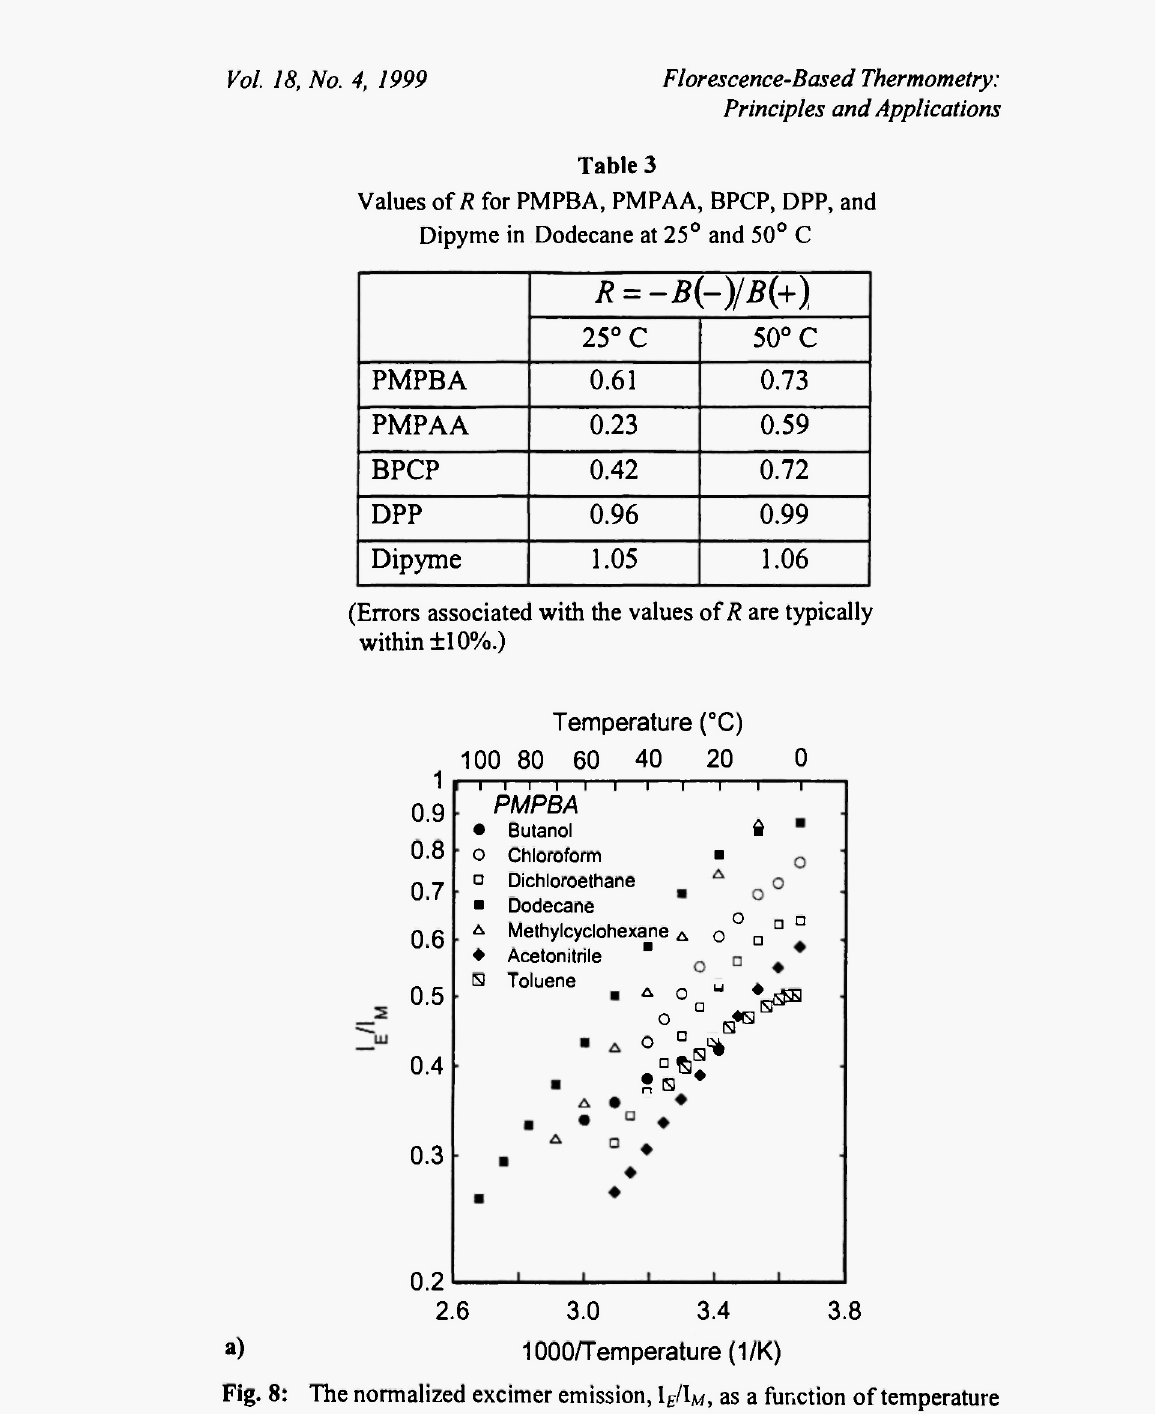
Values of/? for PMPBA, PMPAA, BPCP, DPP, and Dipyme in Dodecane at 25° and 50°